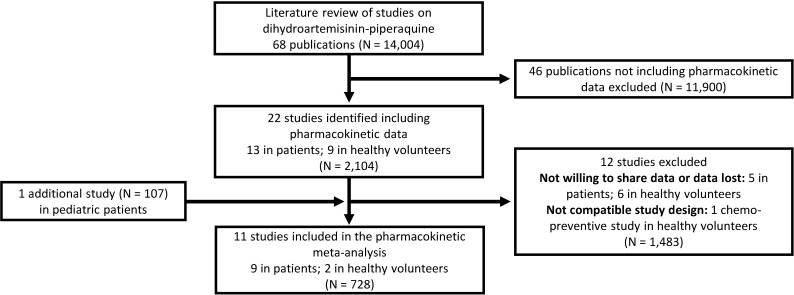
Flowchart of the literature search.